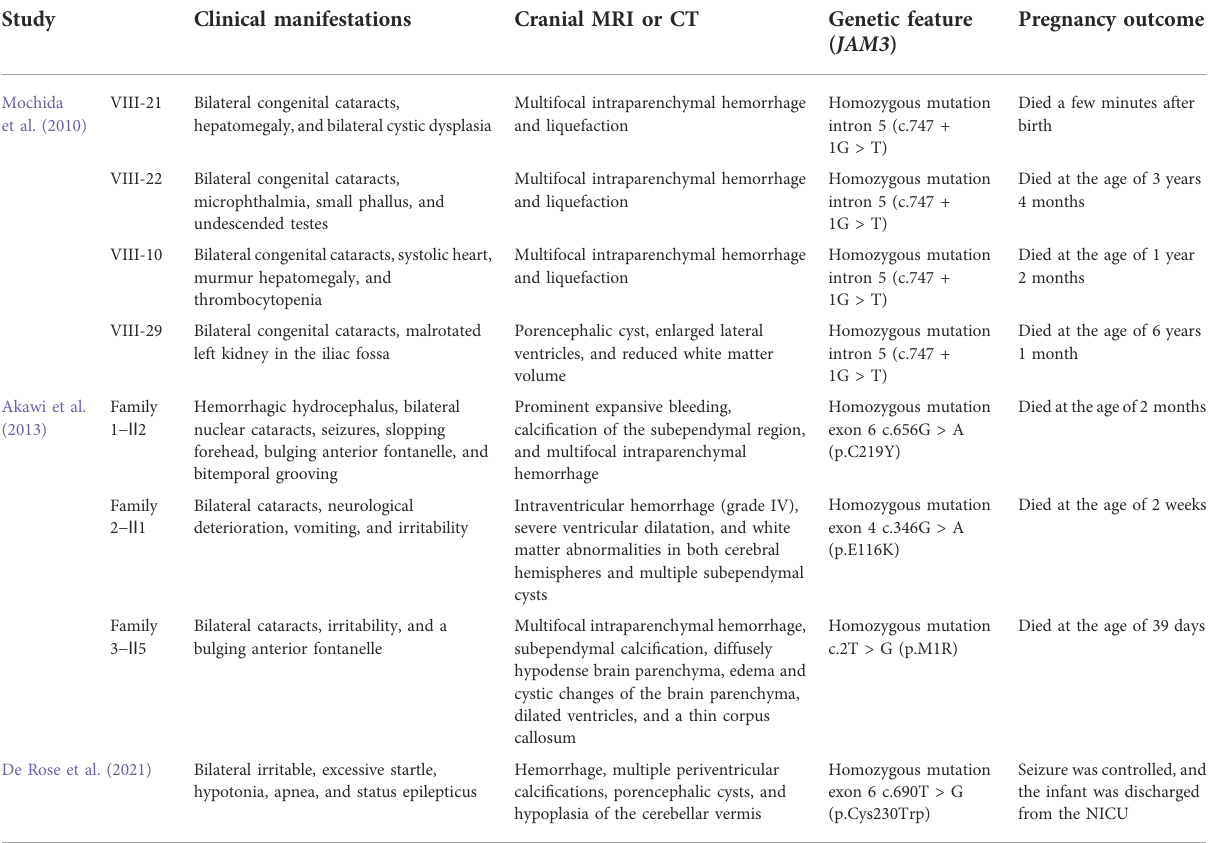
TABLE 1 Summary of clinical and genetic features of mutations in the JAM3 gene leading to fetal ICH.